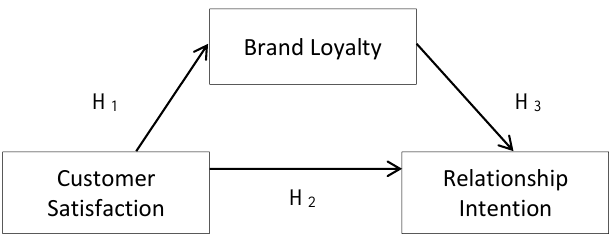
Figure 1: The theoretical